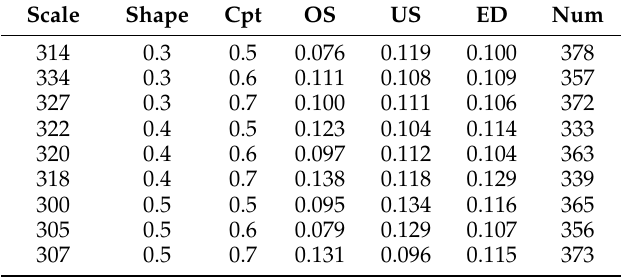
Table 6. Segmentation accuracy metrics for Ansai based on DOM strategy.